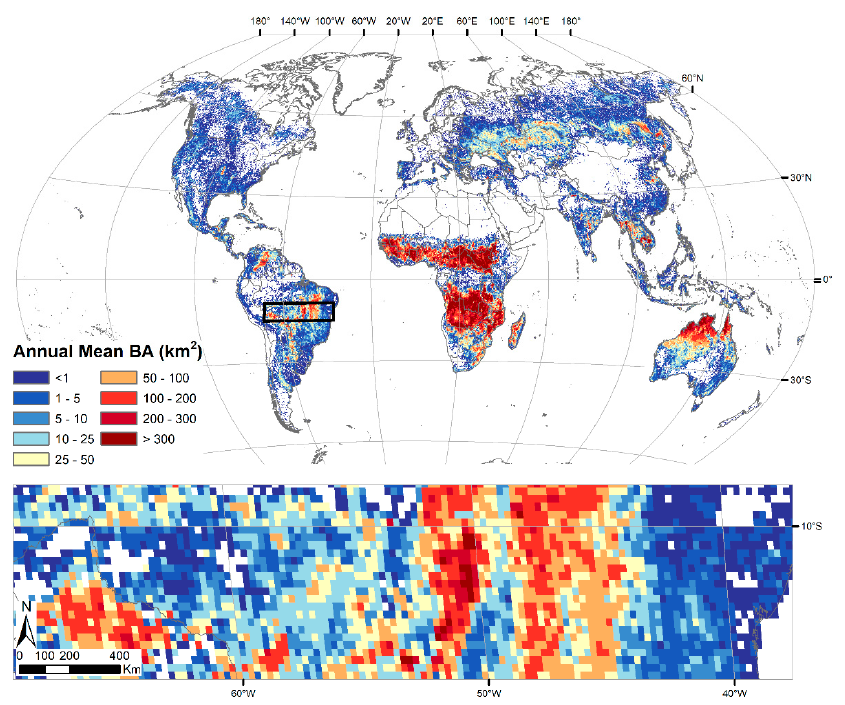
Figure A2. Spatial distribution of the mean burned area (see main text for definition and further details). The bottom panel shows a zoomed region in central South America, as delineated in the global map.